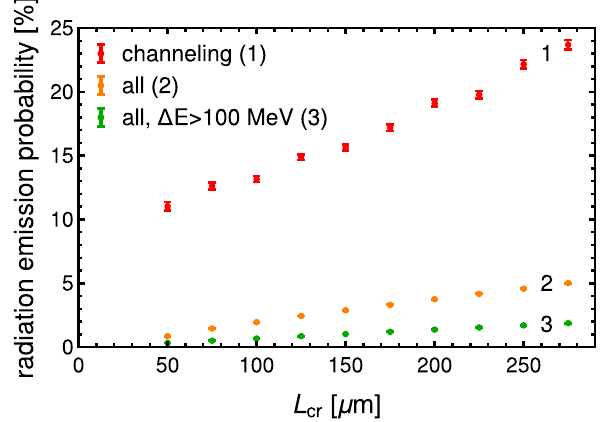
Fig. 11 Radiationemissionprobabilityasfunctionofthecrystalthick- ness for (1) the channeled particles which were selected according to θ > θ − θ x b L (red dots), for (2) all particles (yellow dots), and for (3) particles with radiation energy losses exceeding 100 MeV (green dots). The simulations were done for a Si crystal, bent along the (111) planes with a deflection angle of 1.75 mrad. The low-energy cut is 1 MeV. The incoming beam distribution is the same as in Fig.